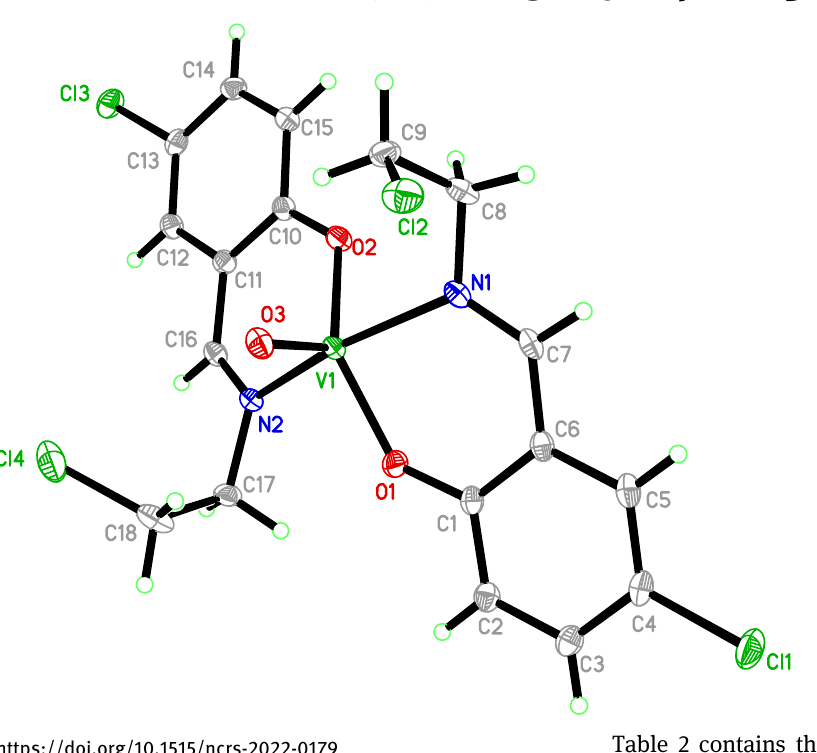
coordinates and displacement parameters.